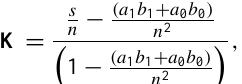
Figure 3. Kappa coefficient, K , quantifying the agreement between model-derived and Wang06 maps (see Sect. 3.3). K ≥ 0.2 indicates at least fair agreement with the Wang06 map. The lower triangle is K for the whole TP and is only available for CLM4.5, CoLM, JULES and UVic, while the upper triangle is K for the common modeling